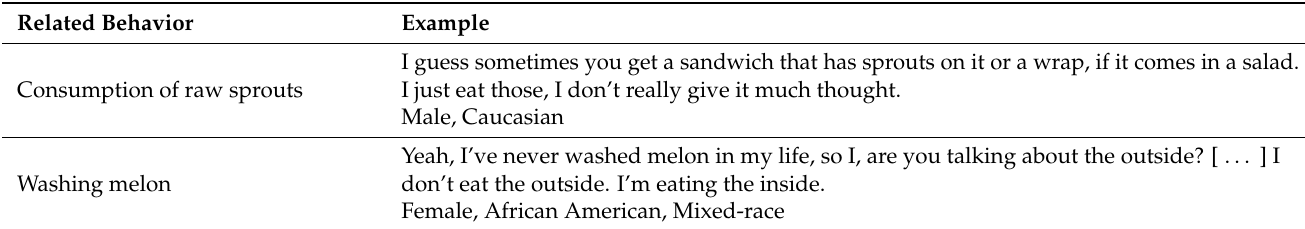
Table 3. Food handling behaviors related to produce, with supporting quotes from the focus group discussions.